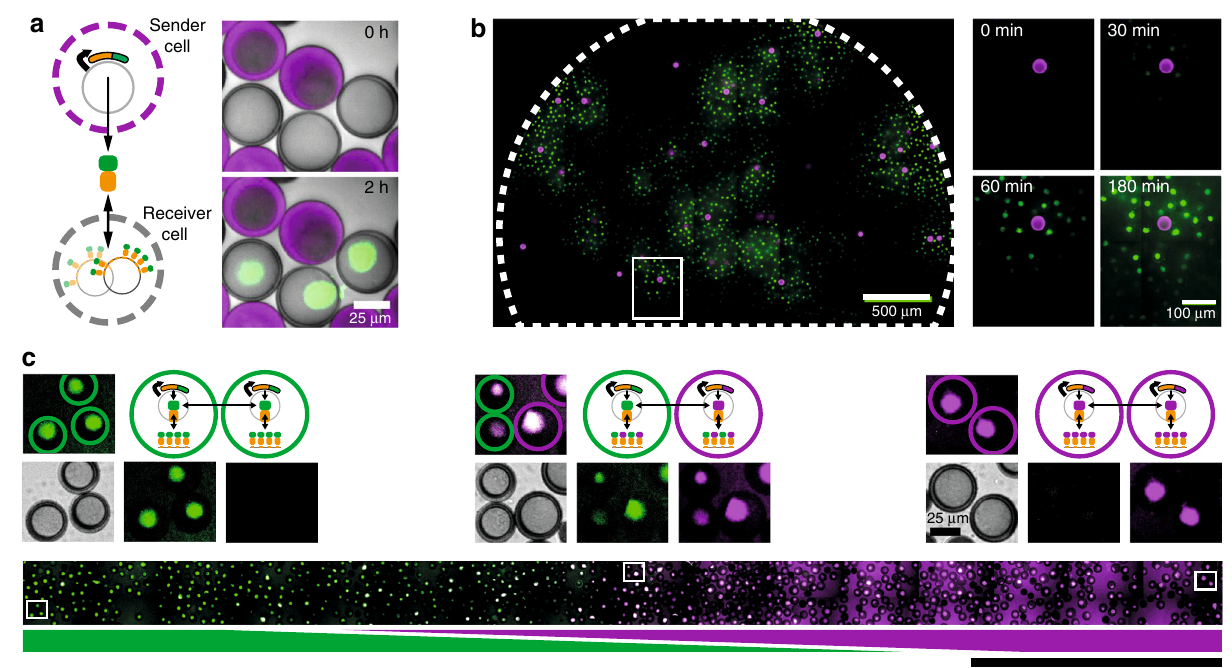
Fig. 2 Protein exchange between neighboring and distant cell-mimics. a Schematic of diffusive TetR-sfGFP exchange between neighboring sender and receiver cell-mimics and timelapse images of neighboring senders (rhodamine B stained membranes) and receivers (unstained membranes). Merge of bright fi eld and fl uorescence channels (sender membranes, magenta; TetR-sfGFP, green). b Distribution of TetR-sfGFP (green) in a dense droplet of receivers and sparse senders (magenta) after 3 h of expression. A small region around a sender (white box) is magni fi ed and spreading of fl uorescence is shown at different time points. c Inhomogeneous mix of two types of cell-mimics producing and binding different color reporter proteins. tetR -sfGFP / tetO (green) and tetR -mCherry / tetO cell-mimics (magenta) were distributed in a channel to stay separate at the sides and mix in the center. Bottom image shows the distribution of sfGFP and mCherry fl uorescence after 5 h. Merge of the two channels results in a white signal (middle). Magni fi ed images from indicated positions along the channel are shown above. Merged image with cell-mimic types indicated by colored, dashed circles (top), and bright fi eld, sfGFP and mCherry signals shown separately